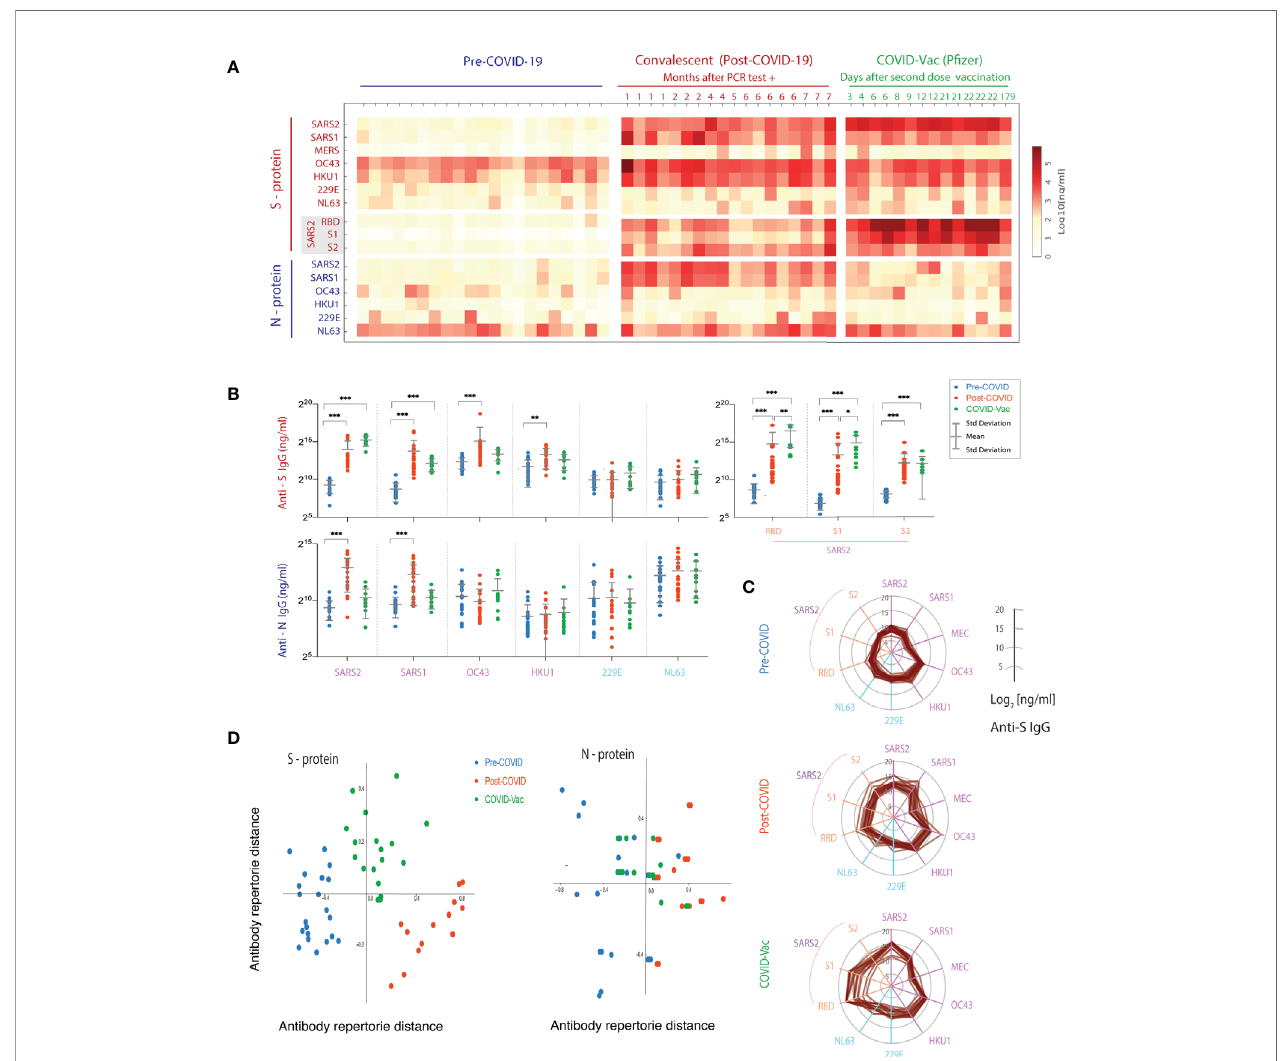
FIGURE 5 | Spike (S)- and nucleocapsid (N)-reactive IgG antibody levels to human coronaviruses (HCoVs) in VAMS blood samples of pre-COVID, convalescents, and post-vaccination subjects. (A) The IgG concentrations (ng/mL) of each S and N-reactive IgG antibodies against HCoVs. The heatmap shows mean concentration (ng/ml) of duplicate samples. (B) Comparison of differences in range of anti-HCoV S- and N- protein IgG between pre-, post-COVID and post- vaccination cohorts. (***p < 0.001, **p < 0.01,*p < 0.05). (C) The broad cross-reactive anti-S IgG antibody concentrations of HCoVs in three cohorts shown in multivariate spider plots, with each axis representing log2 IgG concentrations. (D) Multidimensional Scaling (MDS) analysis of the VAMS